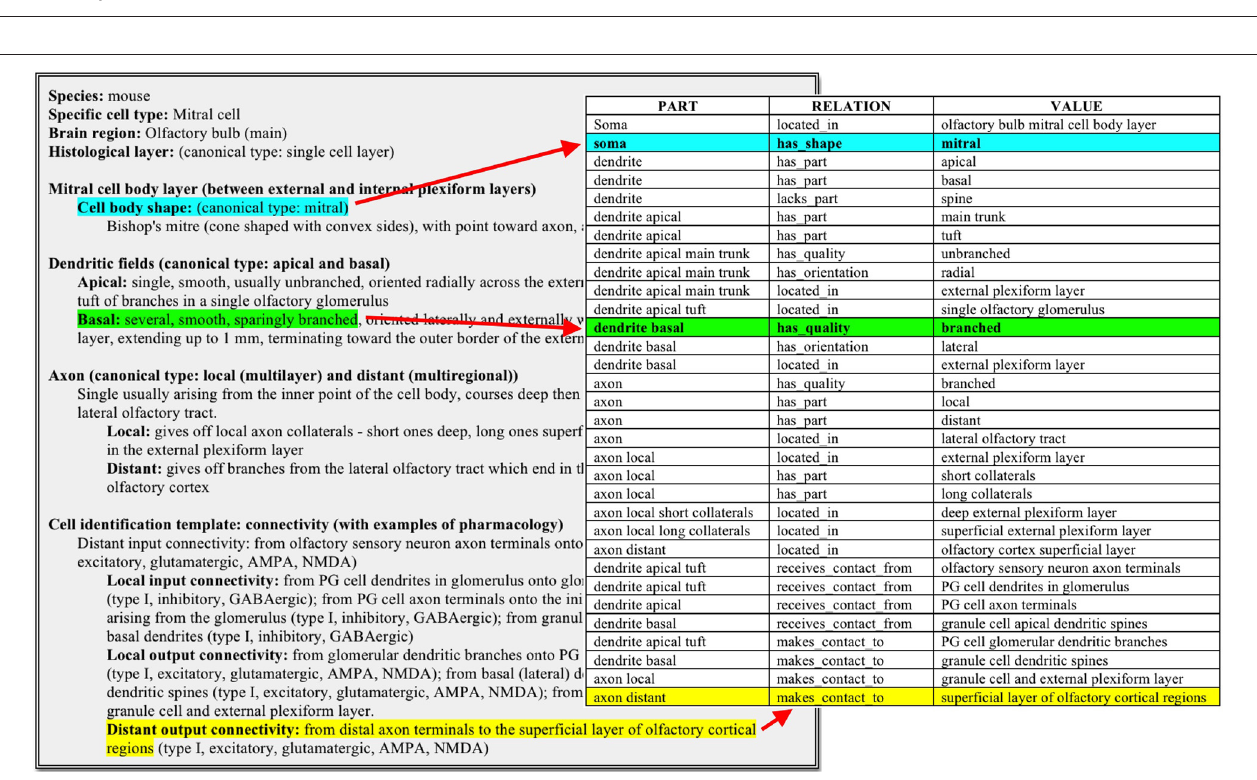
FIGURE 7 | Mapping of a freeform neuronal description of the defining properties of an Olfactory bulb (main) mitral cell into a part-relation-value ontological description.